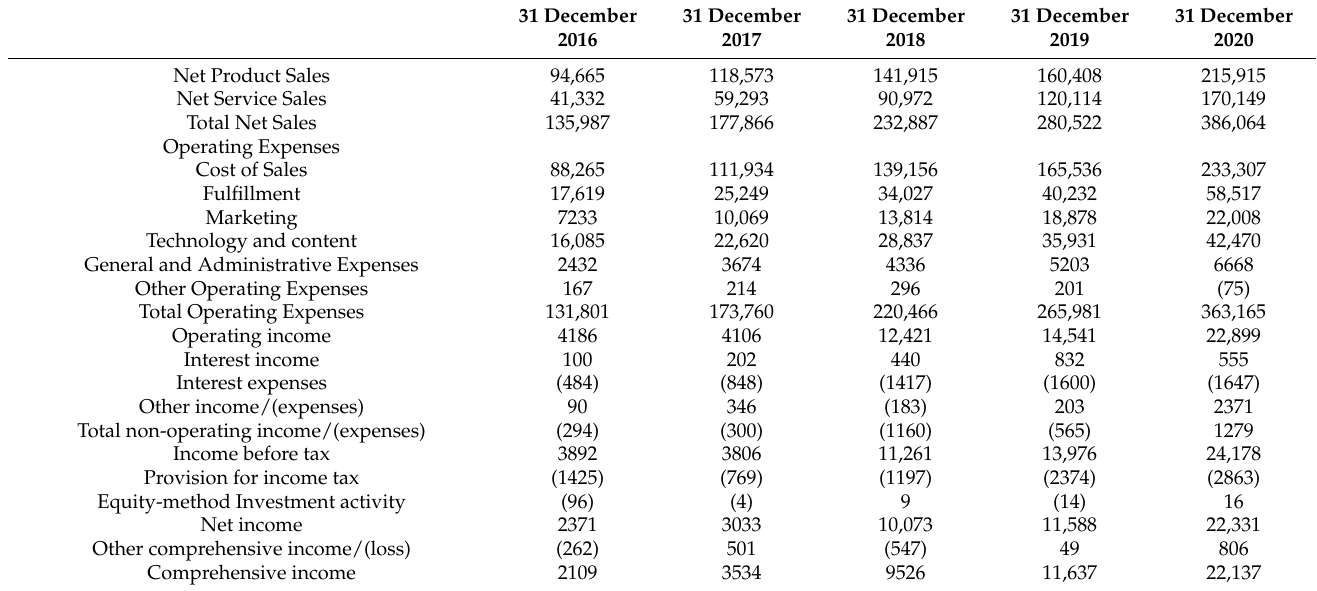
Table 2. Amazon’s annual income statement for the 2016–2020